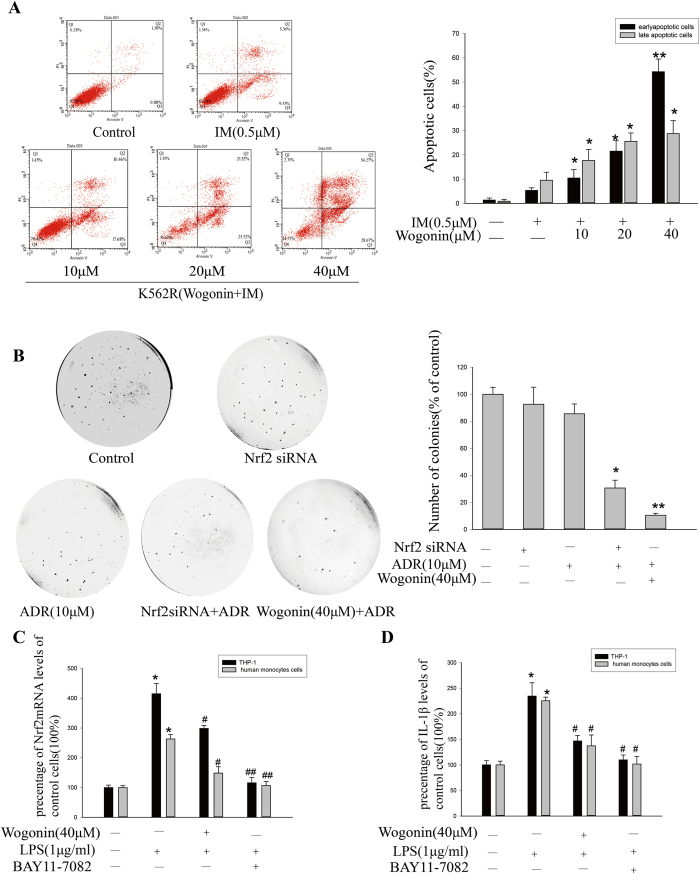
Wogonin enhanced chemotherapy-induced apoptosis via inhibition of Nrf2.(A) K562R cells were treated with or without 0.5 μM IM in the absence or presence of Wogonin for 24 h, respectively. Annexin V/PI double-staining assay of treated K562/A02 cells was analyzed by flow cytometry. *p < 0.05 versus treatment with IM. (B) Soft-sugar-colony forming experiment was performed to ascertain Wogonin reversal effect by Nrf2 signaling. *p < 0.05 and **p < 0.01 versus control. (C) Human monocytes and THP-1 cells were treated with LPS in the absence or presence of BAY11-7082 and Wogonin. Levels of Nrf2mRNA in treated cells were determined by RT-PCR. *p < 0.05 versus control. #p < 0.05 and ##p < 0.01versus LPS (1 μg/ml). (D) Human monocytes and THP-1 cells with LPS in the absence or presence of BAY11-7082 and Wogonin. IL-1β secretion was determined by ELISA after treatment. *p < 0.05 versus control. #p < 0.05 versus LPS (1 μg/ml). All results were represented as the mean ± SD of three independent experiments.